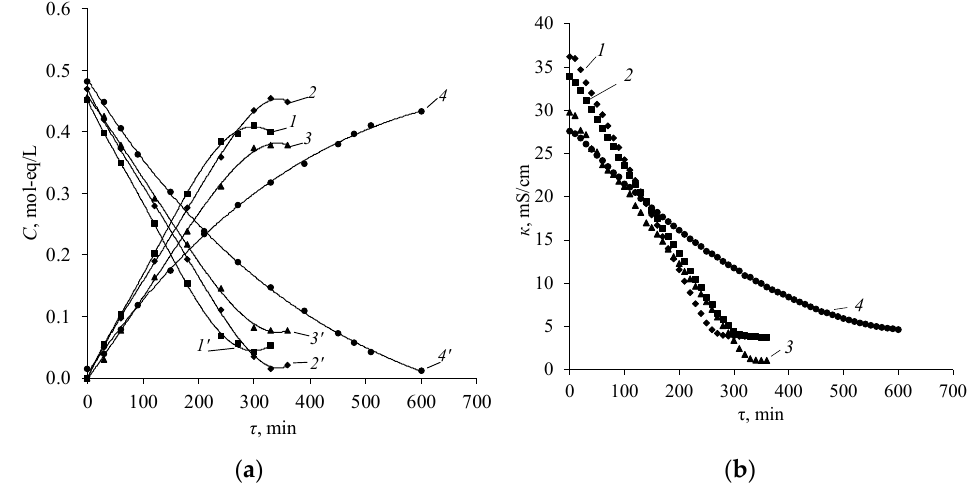
0.00.10.20.30.40.50.6 Figure 13. Dependence of the concentrations of sulfuric acid ( 1 , 2 , 3 , 4 ) and amines salts ( 1’ , 2’ , 3’ , 4’ ) ( a ) and the specific electrical conductivity ( b ) in the solution circulating through the acid compartments of the electrodialyzer using Ralex AMH anion-exchange membranes on the operating time in the process of production: 1 , 1’ —MA, 2 , 2’ —DMA, 3 , 3’ —EDA, 4 , 4’ —DEA. The solid lines show the approximating curves. Figure 14. Dependence of the concentrations of sulfuric acid ( 1 , 2 , 3 , 4 ) and amines salts ( 1’ , 2’ , 3’ , 4’ ) in the solution circulating through the acid compartments of the electrodialyzer using Ralex AMH anion-exchange membranes on the operating time in the process of production: 1 , 1’ —MA, 2 , 2’ —DMA, 3 , 3’ —EDA, 4 , 4’ —DEA. The solid lines show the approximating curves. The integral current efficiencies of sulfuric acid and amines decrease with an increase in their concentration (Figure 15). In the case of sulfuric acid, the decrease is due to a greater extent of the hydrogen ions leakage from acid to the base-salt chamber across the anion-exchange membrane and to a lesser extent to the migration of the sulfate anion across the bipolar membrane. High effective transport numbers of hydrogen ion through the Ralex AMH anion-exchange membrane in the «DEA, (DEA) 2 H 2 SO 4 –H 2 SO 4 » system are confirmed in